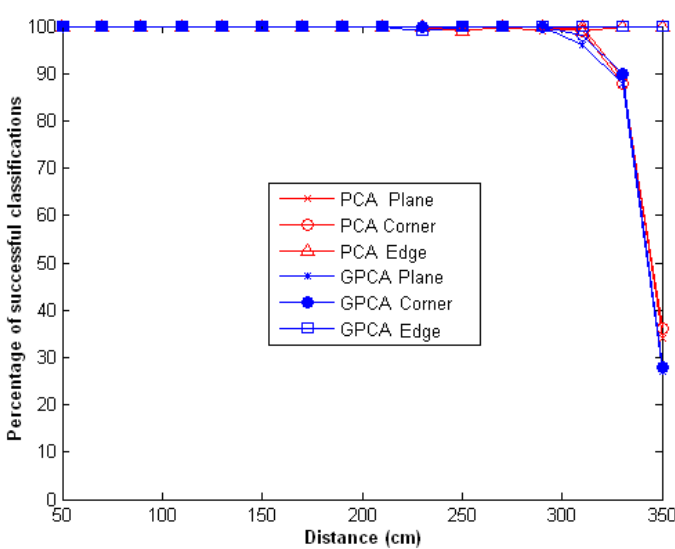
Figure 4. Percentage of successful classifications using GPCA and PCA, for l = l and m =